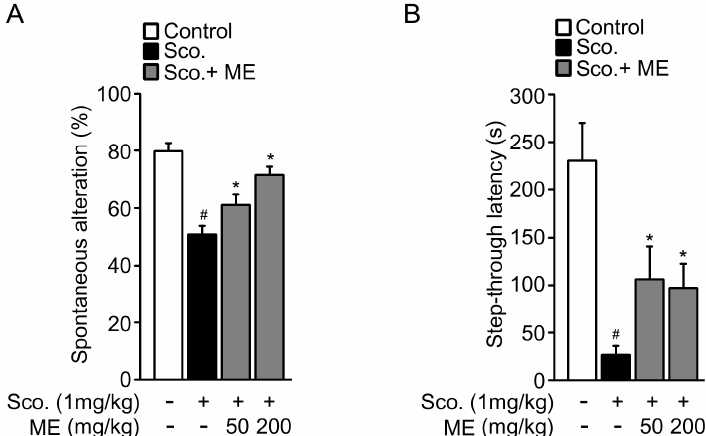
Figure 5. Effects of Melandrii Herba extract on scopolamine-induced cognitive impairment in mice. ( A ) Results from the Y-maze test (n = 7–8 per group); ( B ) Results from the passive avoidance test (n = 7–8 per group). * p < 0.05, significantly different from the scopolamine-treated control group. # p < 0.05, significantly different from the untreated control group.